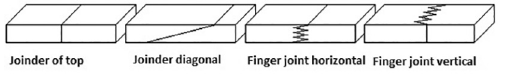
Figure 1: Types of joints 1 . Table 1: Geometric specifications for teeth recommended by NBR 7190. Parameter